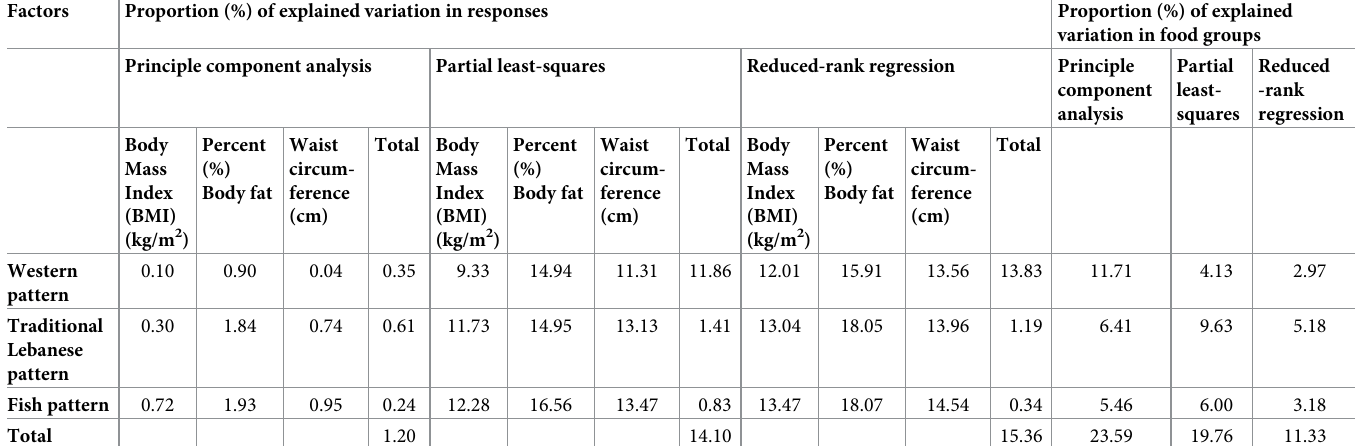
Table 3. Explained variation (%) in response and food groups by dietary patterns identified using principle component analysis, reduced-rank regression and par- tial least-squares (n = 673). Factors